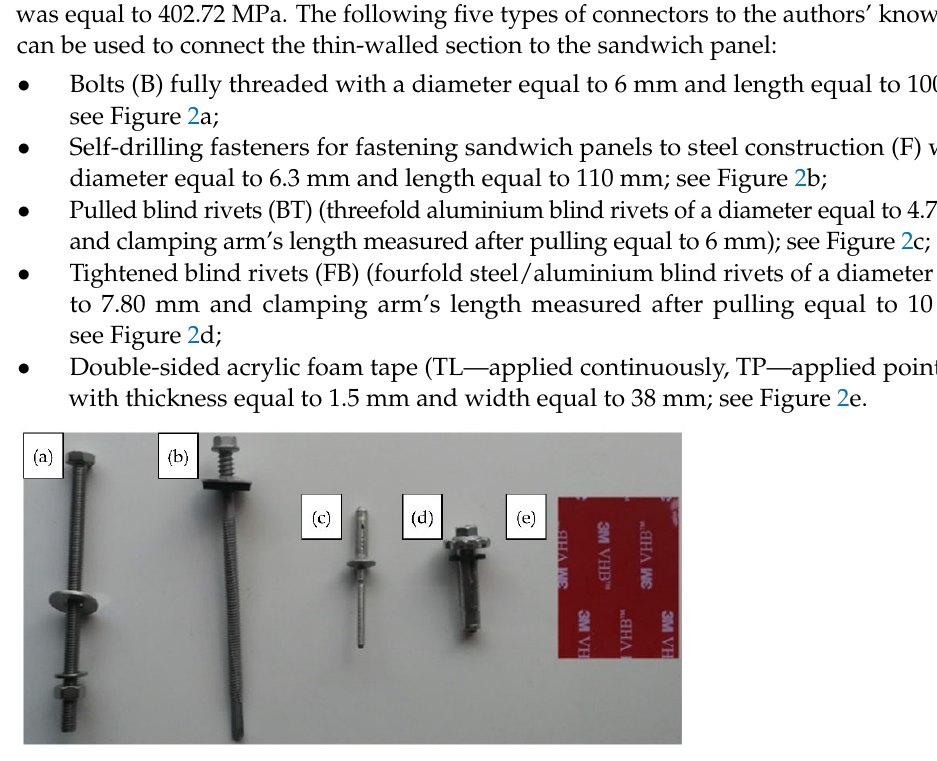
Figure 2. Connectors used to join the thin-walled beam and the sandwich panel (description in the text): ( a ) bolt (B), ( b ) self-drilling fastener dedicated for sandwich panels (F), ( c ) pulled blind rivet (BT), ( d ) tightened blind rivet (FB), ( e ) acrylic tape (TL, TP).